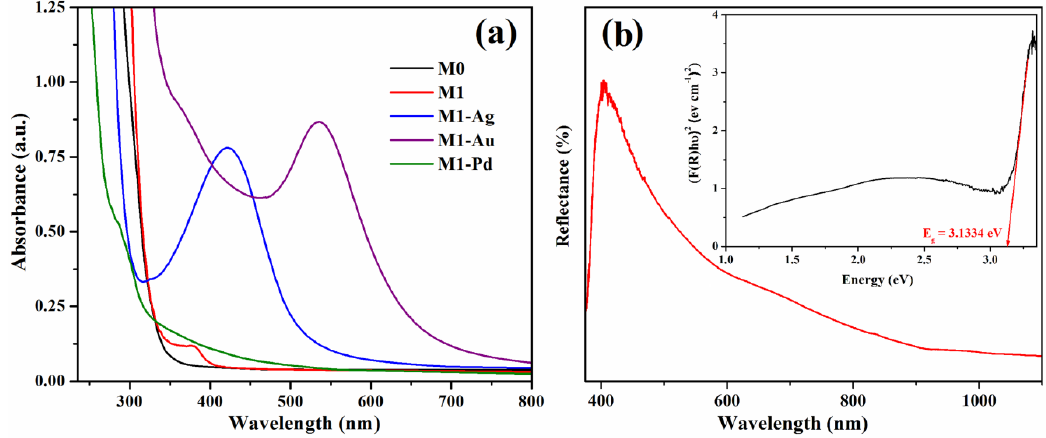
Figure 5. UV-vis absorption spectra for M0, M1, M1-Ag, M1-Au and M1-Pd samples ( a ) and reflectance spectrum of M1 film ( b ). Inset of ( b ) representation of Kubelka–Munk function for M1